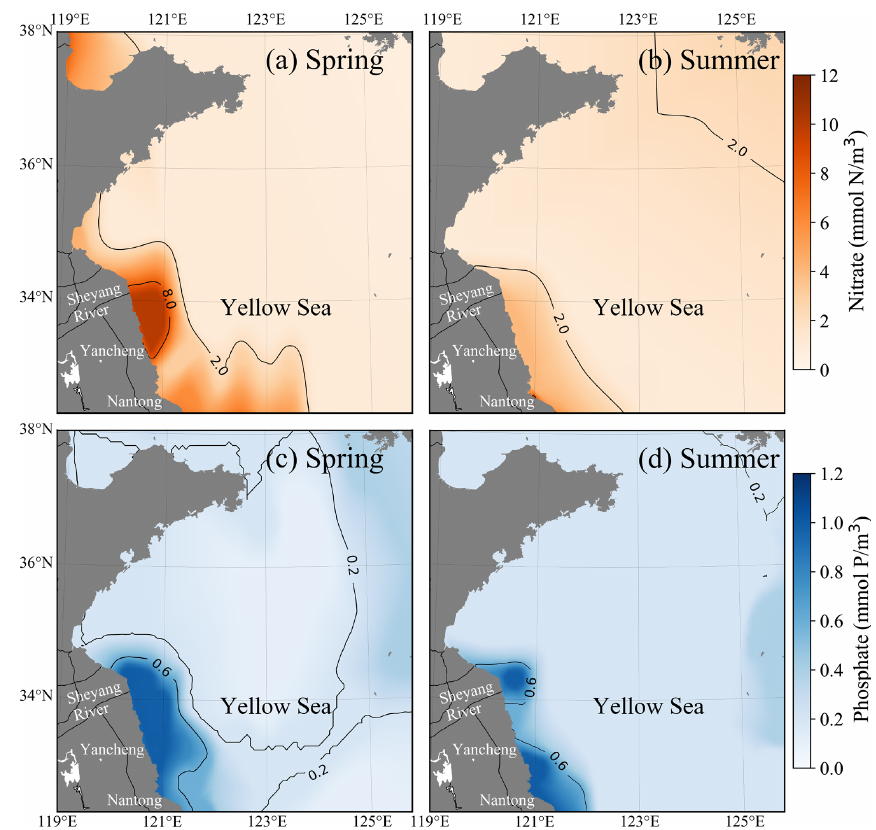
Figure 7. Seasonally averaged surface distributions of nitrate (a,b) and phosphate (c,d) in the YS during spring (a,c) and summer (b,d) .